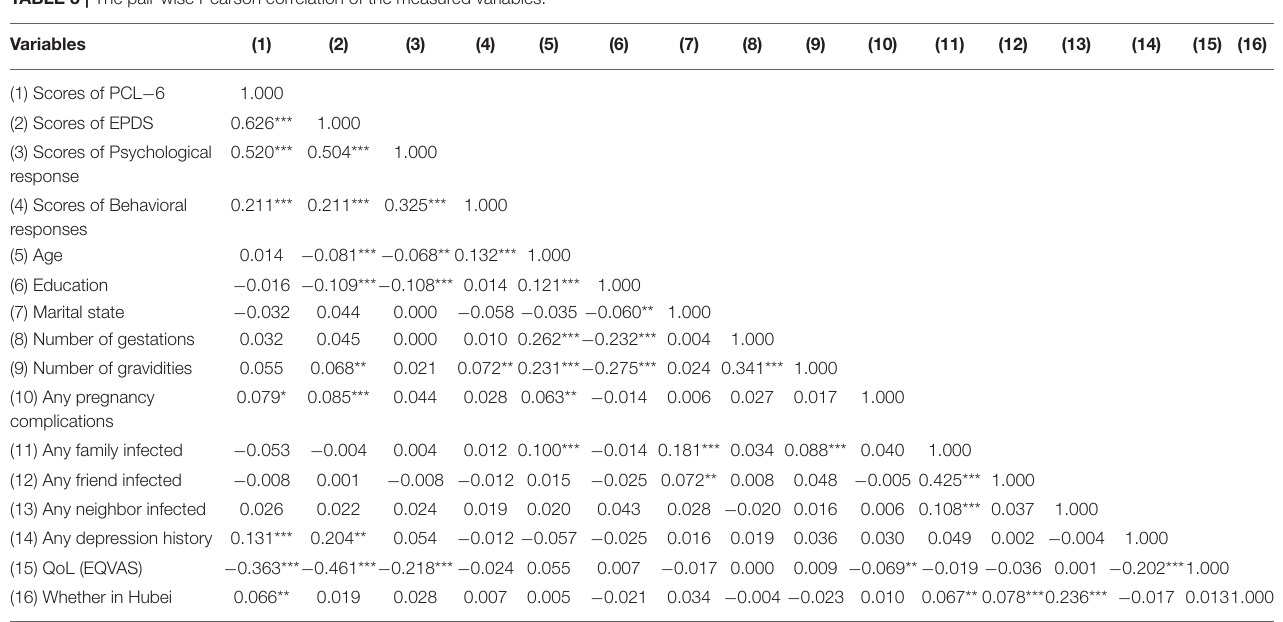
TABLE 3 | The pair-wise Pearson correlation of the measured